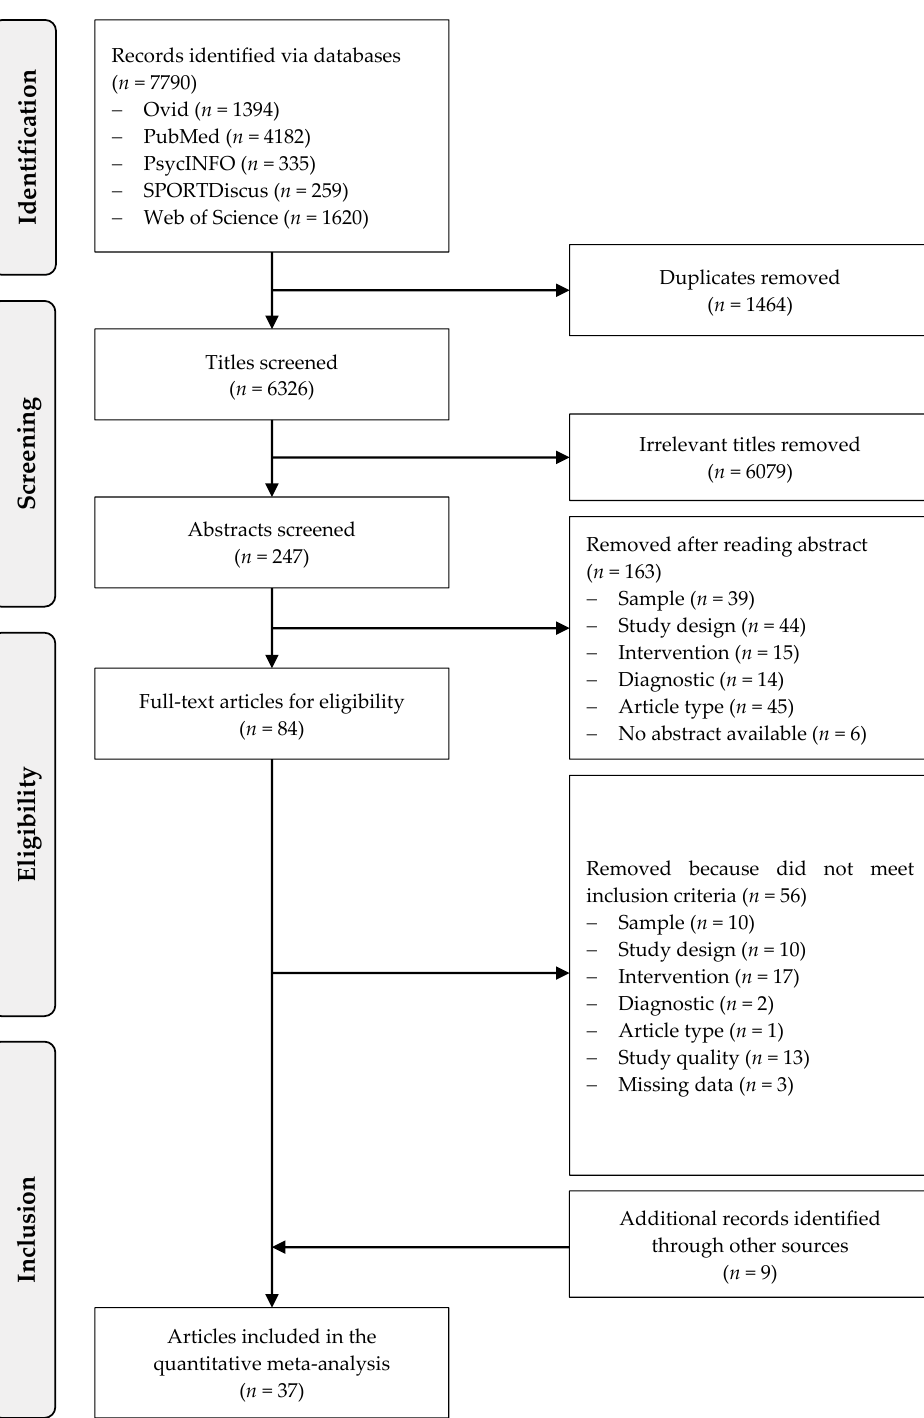
Figure 1. Flow of study screening and